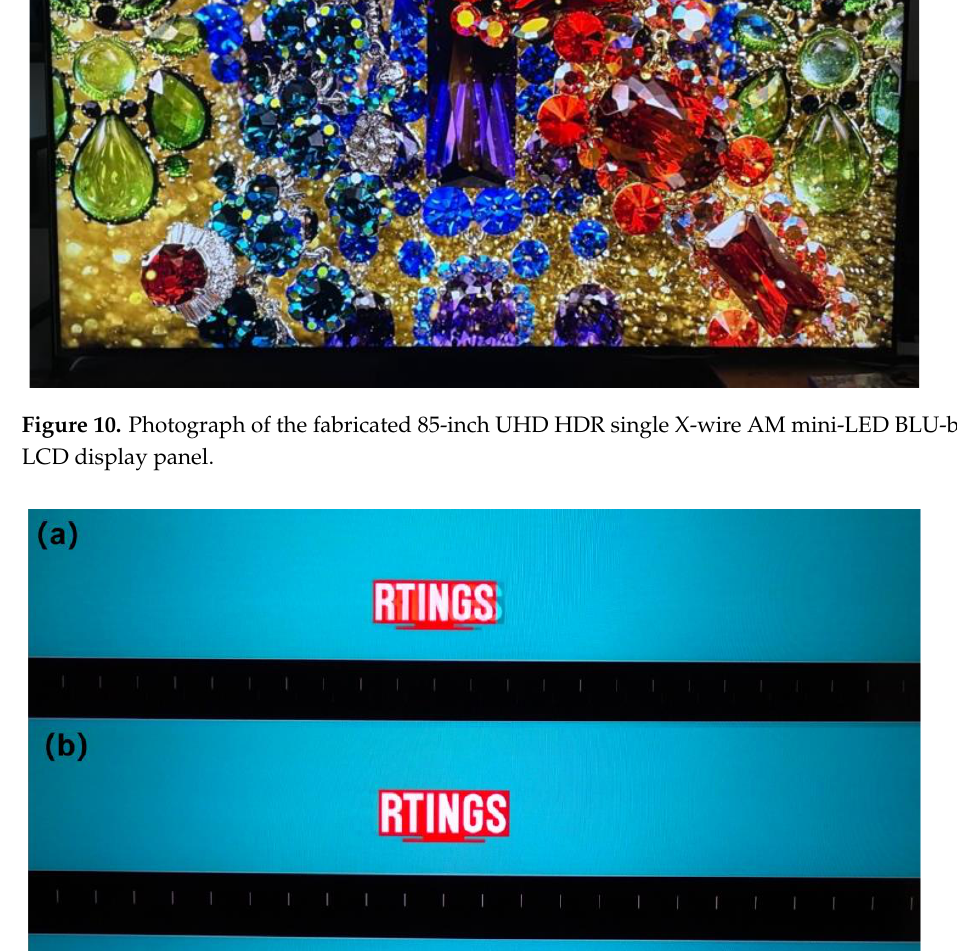
Figure 11. Comparison between image quality ( a ) without H-scan and ( b ) with H-scan . Table 1. Performance summary between proposed single X-wire AM mini-LED BLU and conventional mini-LED BLU.